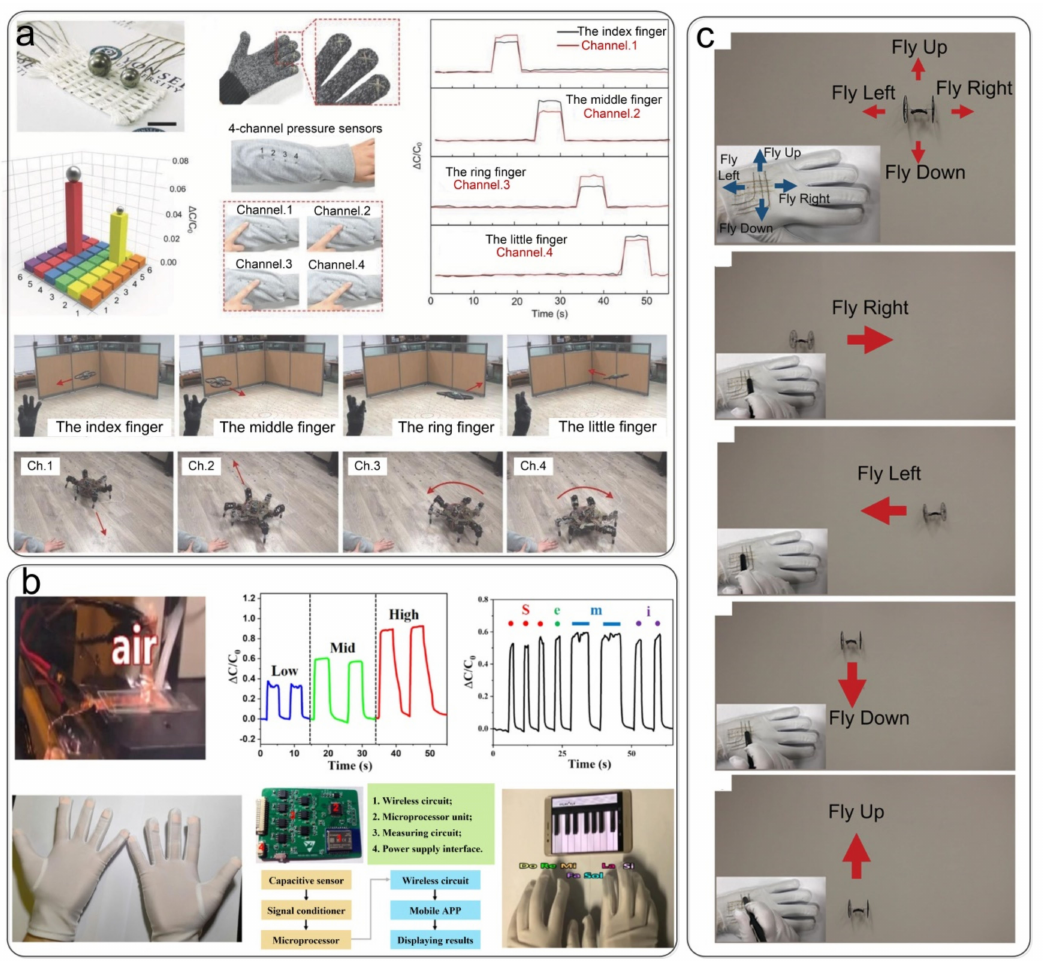
Figure 12. Pressure sensors are used for human–machine interaction. ( a ) The textile capacitive pressure sensor is used for wireless control of a UAV quadrotor and hexapod walking robot. Repro- duced with permission from Ref. [111]. Copyright 2015 Wiley-VCH. ( b ) Capacitive tactile sensors are used to play a piano. Reproduced with permission from Ref. [104]. Copyright 2020 American Chemical Society. ( c ) Smart gloves for the remote control of drones. Reproduced with permission from Ref. [130]. Copyright 2020